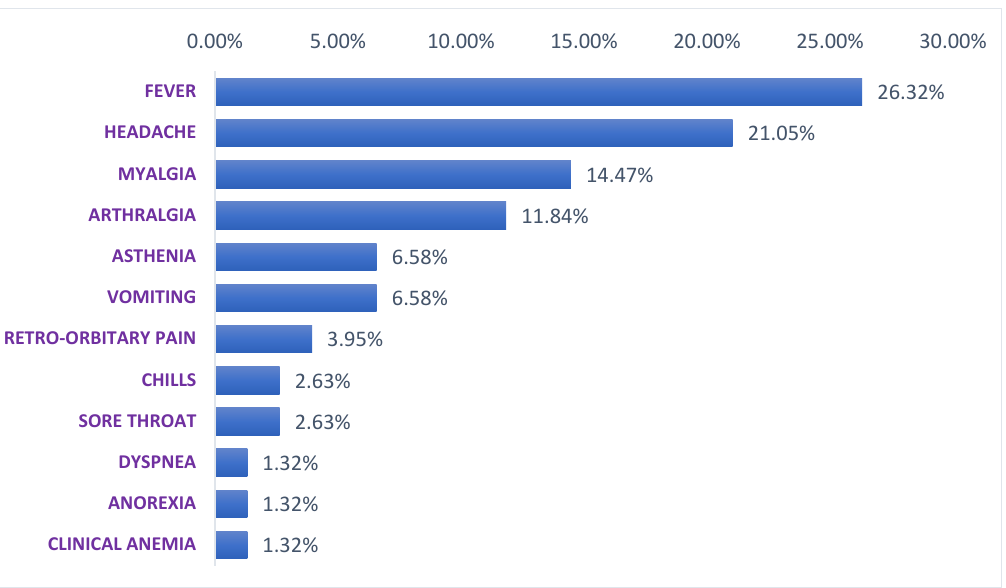
Figure 3. Number of WNV-positive human cases relative to the total number of suspected individuals.